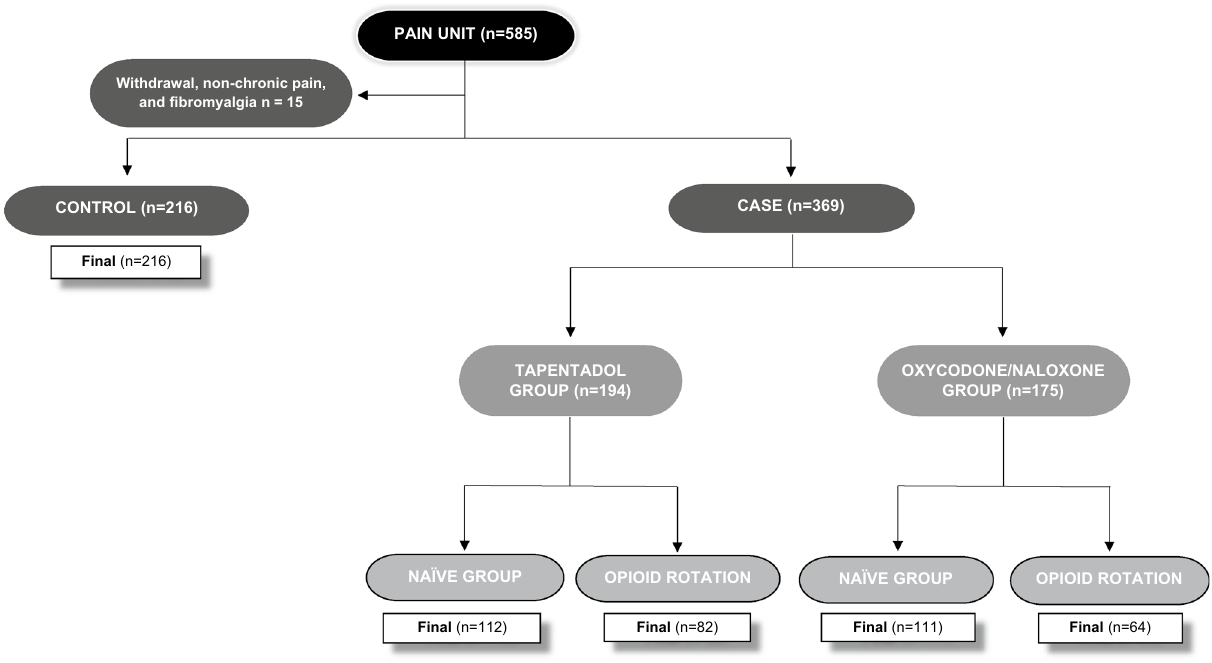
Figure 5. Study flow chart of patients’ selection and